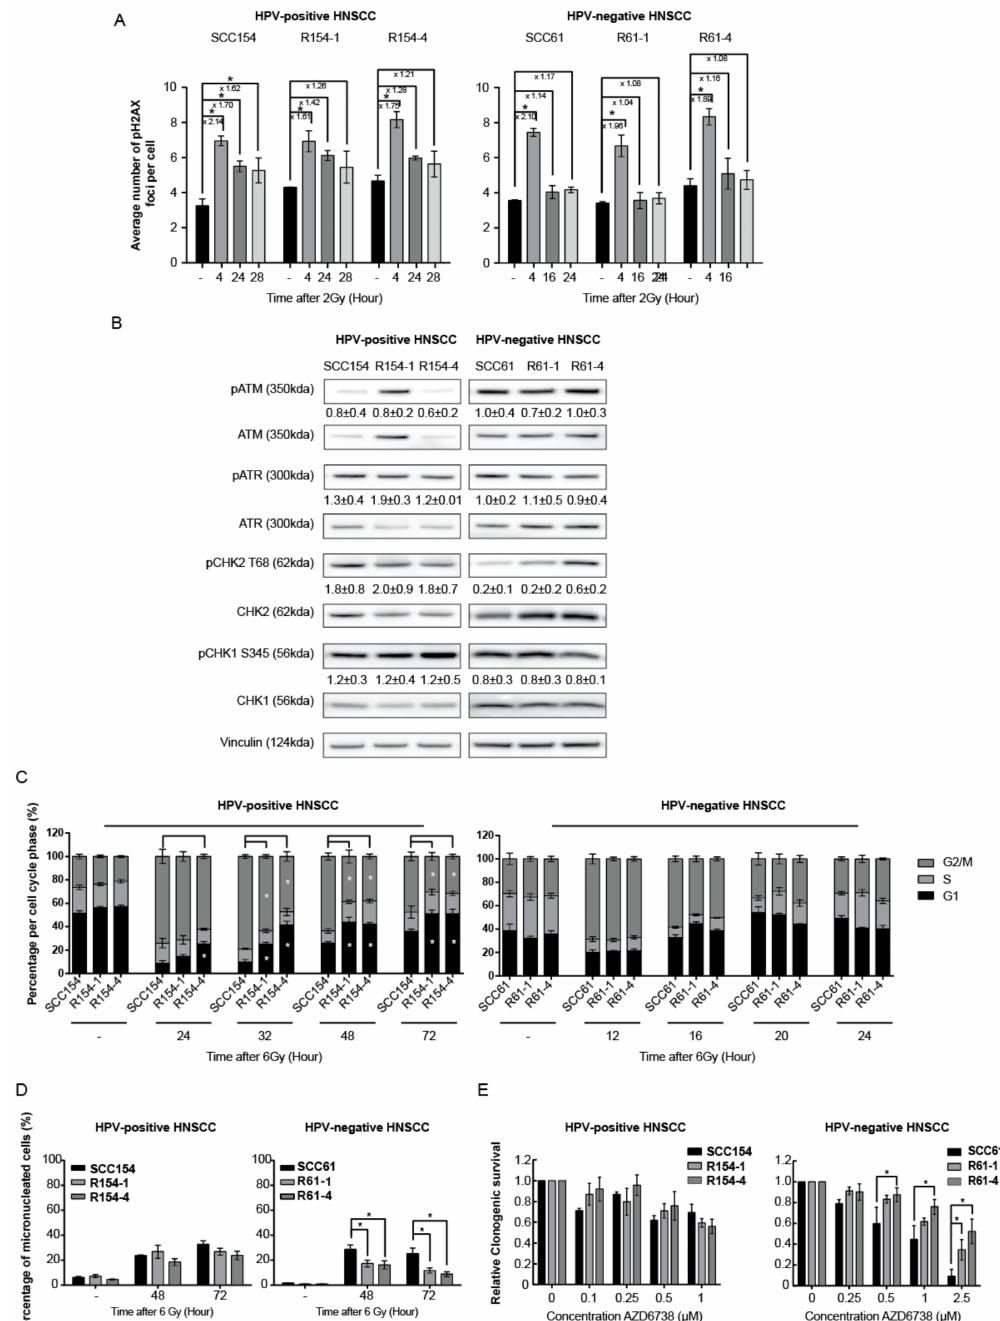
Figure 2. HPV-positive and HPV-negative radioresistant HNSCC clones show differences in the involvement of the DNA damage response. ( A ) Average number of γ H2AX foci per cell was determined in untreated cells ( − ) and at indicated time points after a RT dose of 2 Gy. ( B ) Baseline protein levels of pATM (350kDa), ATM (350kDa), pATR (300kDa), ATR (300kDa), pCHK2 T68 (62kDa), CHK2 (62kDa), pCHK1 S345 (56kDa), CHK1 (56kDa) and Vinculin (124kDa) in HPV-positive and HPV-negative parental and radioresistant cells. KDa is the molecular weight as determined by the protein standard. ( C ) Cell cycle distribution (percentage %) in G1, S and G2/M phase was determined at different time points after a RT dose of 6 Gy. ( D ) The percentage of cells with micronuclei was determined at indicated time points after a RT dose of 6 Gy and in unirradiated cells ( − ). ( E ) Relative survival was determined after treatment with indicated concentrations ( µ M) of ATR inhibitor AZD6738. Relative survival was determined by means of clonogenic survival and is shown as the mean ± SEM clonogenic survival fraction of drug treated conditions relative to vehicle treated control cells, n = 3. ( A – E ) Data are presented as the mean ± SEM for n = 3. * p -values < 0.05 were calculated with ANOVA with multiple comparisons